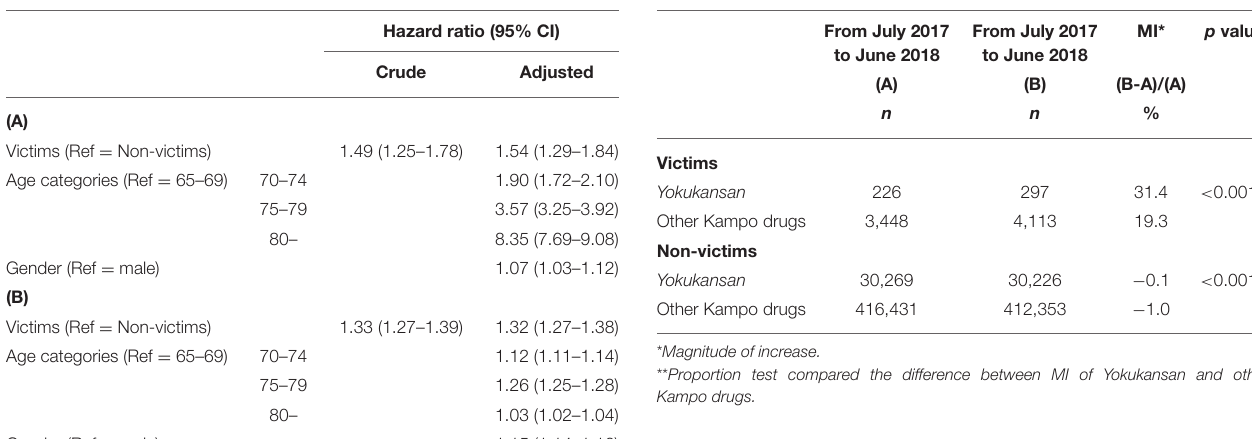
TABLE 3 | Magnitude of increase in the number of subjects prescribed Yokukansan and other Kampo Drugs from before to after the